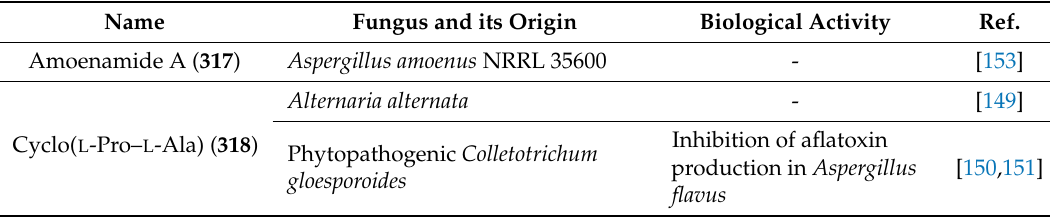
Table 4. Proline-Xaa cyclodipeptide analogs and their biological activities.